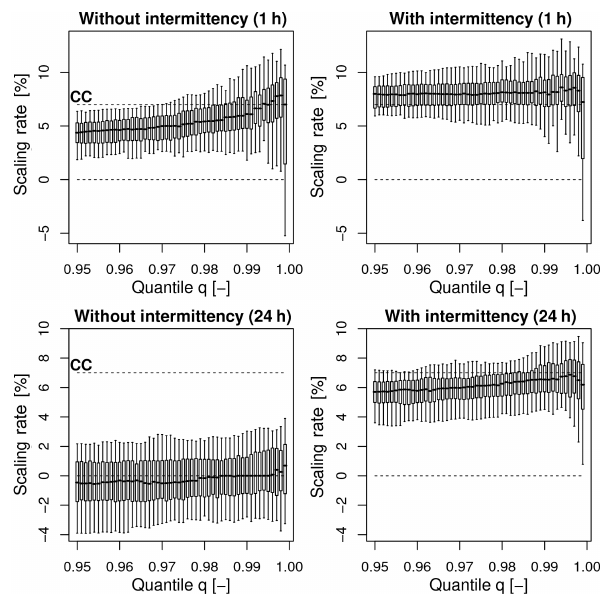
Figure 11. Box plots of rainfall scaling rates with temperature (5– 30 ◦ C) as a function of the quantile q for the 1 and 24h timescales. The model without correction for intermittency is shown on the left. The model with correction for intermittency is shown on the right. Each box plot shows the 10, 25, 50 75 and 90% quantiles of all 99 stations in the